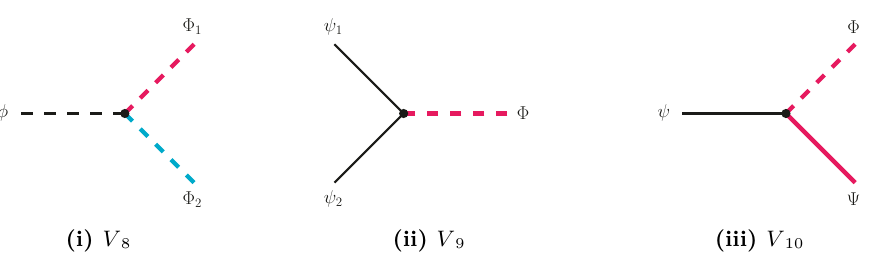
Figure 11. Vertices describing interactions between (i) the SM scalar and two distinct heavy scalars (ii) two SM fermions and a heavy scalar and (iii) an SM fermion and a heavy scalar as well as a heavy